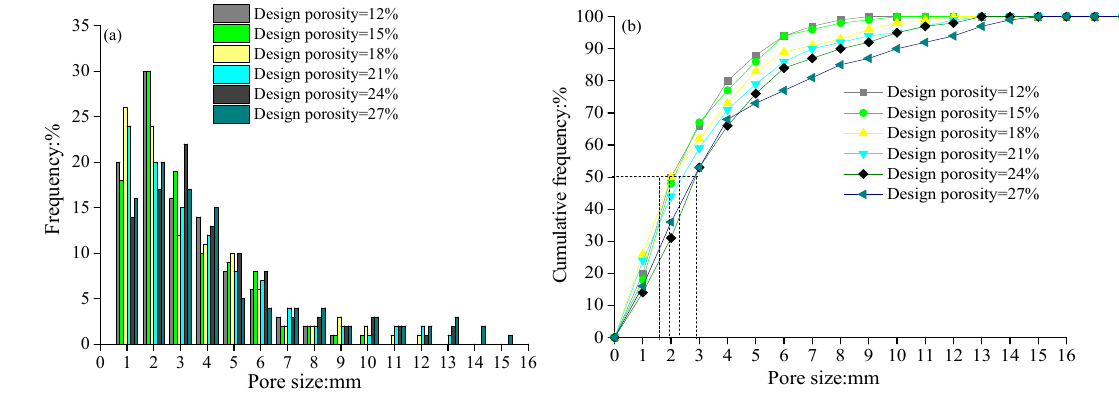
Figure 8. Effect of the design porosity on the pore distribution of pervious concrete. ( a ) Frequency distribution of pore sizes; ( b ) cumulative frequency distribution of pore sizes. The aggregate size was 4.75–9.5 mm. The figure shows the average value of three to five specimens.